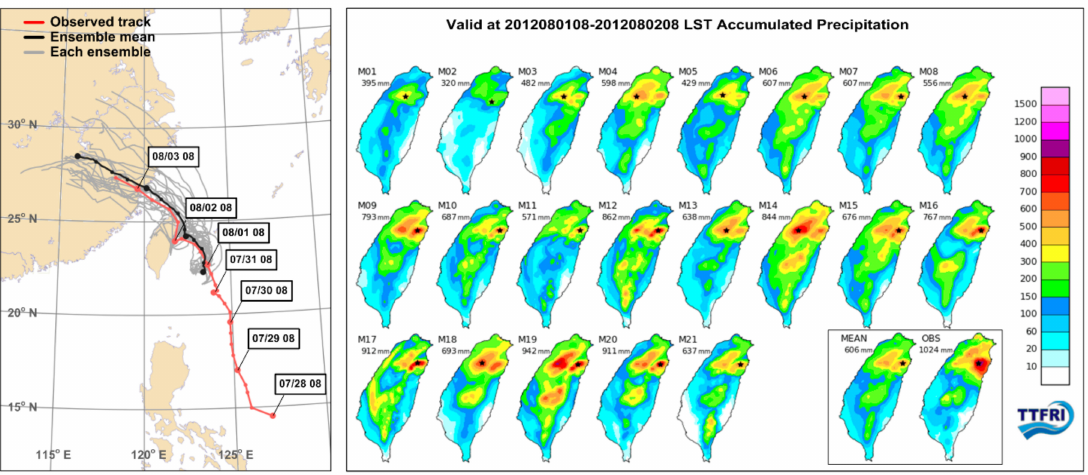
Figure 2. Ensemble forecasts of 72 h typhoon track and 24 h rainfall provided by TTFRI-EPS during typhoon Saola in